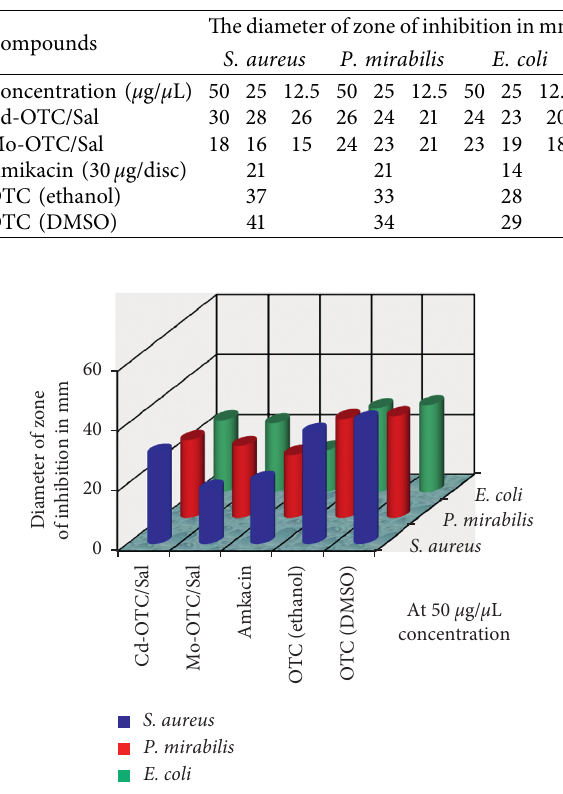
Figure 8: Bar graph showing antibacterial sensitivity at 50 μ g/ μ L concentration.